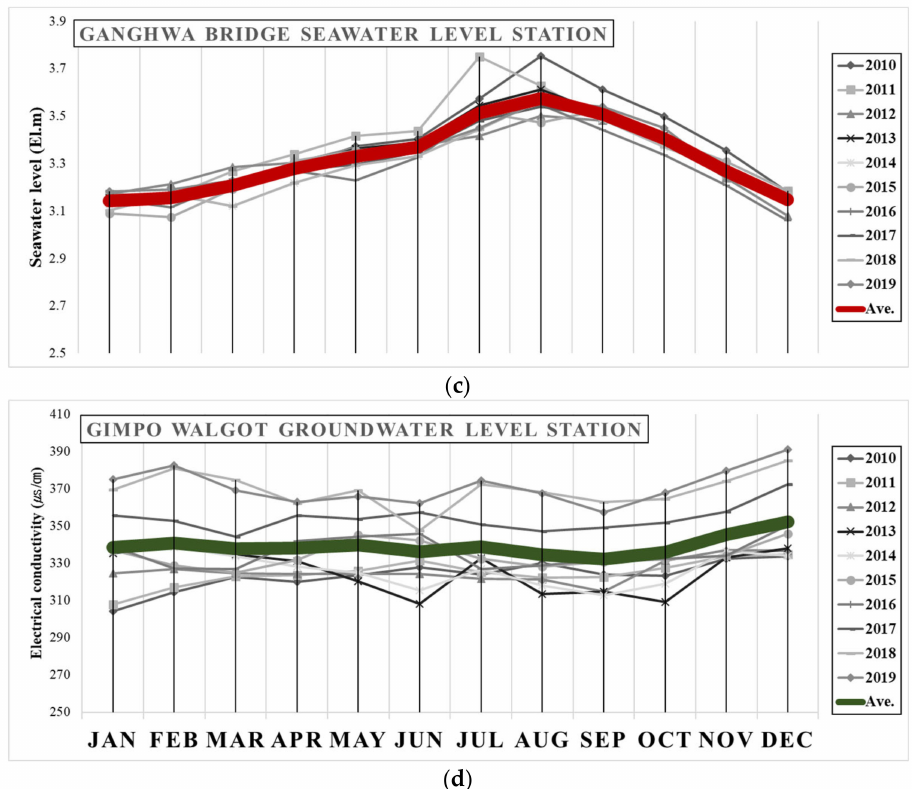
Figure 1. Example of 10-year-averaged monthly ( a ) precipitation, ( b ) groundwater level, ( c ) seawater level, and ( d ) electrical conductivity observation data.